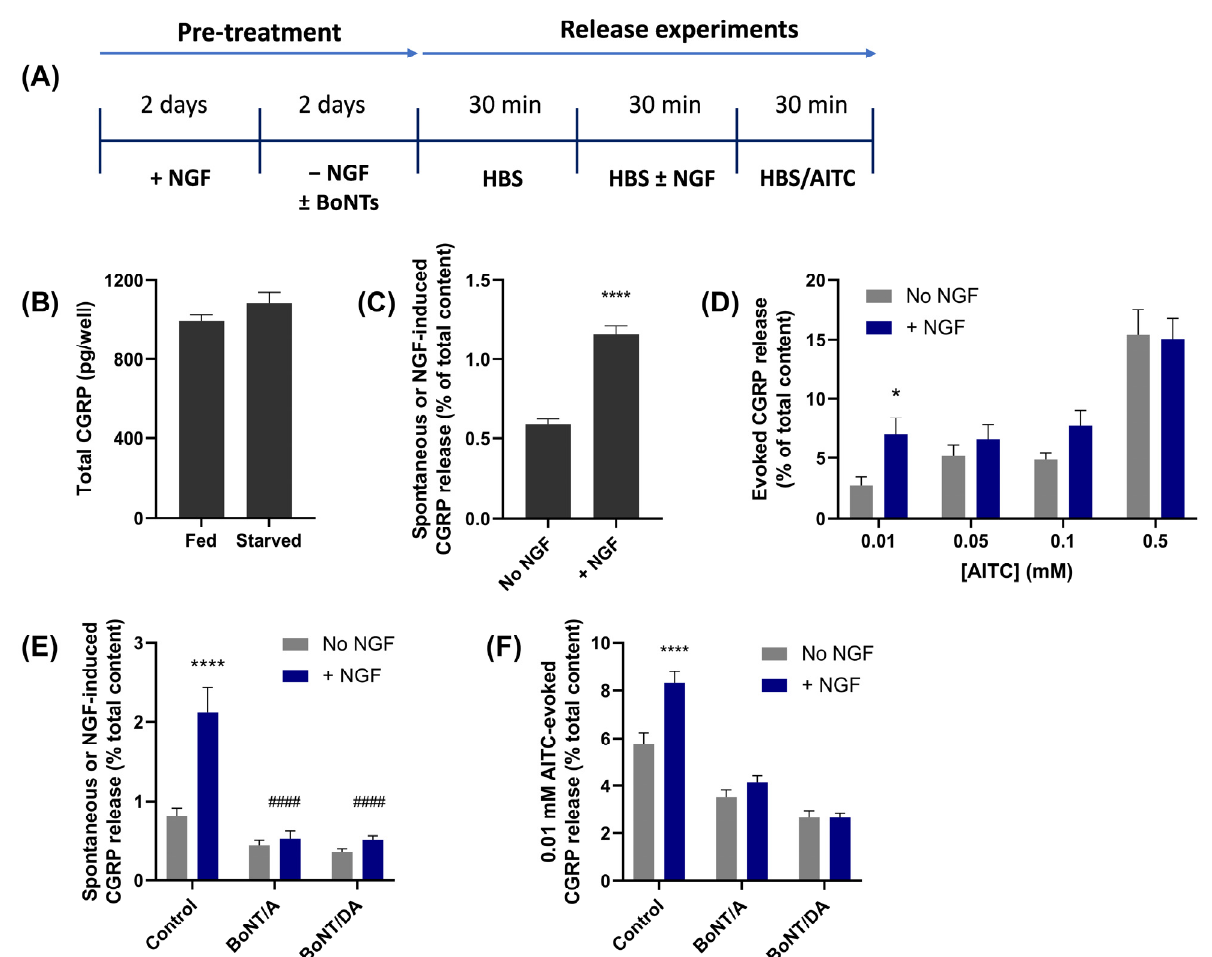
Figure 6. BoNT/A or /DA inhibits both the induction by NGF of CGRP exocytosis and its enhance- ment of 0.01 mM AITC-evoked neuropeptide secretion. ( A ) Timeline for manipulations applied to cultured TGNs: NGF feeding and withdrawal, exposure to BoNTs, and steps performed to determine the effect of acute NGF (100 ng/mL) on CGRP release. ( B ) Similar amounts of CGRP were detected in neurons grown for 4 days in the presence of NGF (Fed) or 2 days with NGF followed by two days without (Starved). ( C – F ) Histograms showing the levels of CGRP release (as a % of total cell content) during 30 min exposure of 2-day NGF-starved TGNs: ( C ) to HBS in the absence (No NGF) or presence of 100 ng/mL NGF (+NGF); ( D ) to various [AITC] from TGNs that had previously been exposed to HBS without (grey bars) or including 100 ng/mL NGF (blue bars) just prior to stimulation with the noxious substance. Two-tailed Welch’s tests were applied to compare responses between NGF-free and − 30 min treated groups at each AITC concentration, * p < 0.05; ( E ) to HBS only (grey bars) or HBS + 100 ng/mL NGF (blue bars) from TGNs that had been deprived of NGF for 48 h in the absence (Control) or presence of 100 nM of the indicated toxins; two-way ANOVA followed by Bonferroni’s post hoc test was used; **** p < 0.0001 for pre-treatment with NGF vs. no NGF; #### p < 0.0001 for NGF-induced in control cells vs. those pre-treated with the indicated BoNTs; ( F ) to 0.01 mM AITC from control or BoNT-pre-treated TGNs that had just been exposed for 30 min to 100 ng/mL NGF (blue bars) or HBS only (grey bars). The significance was tested by two-way ANOVA followed by Bonferroni’s post hoc test; **** p < 0.0001 AITC-evoked CGRP release after pre-treatment with NGF vs. no NGF. N ≥ 2, n = 6 for /A, n = 10 for /DA.